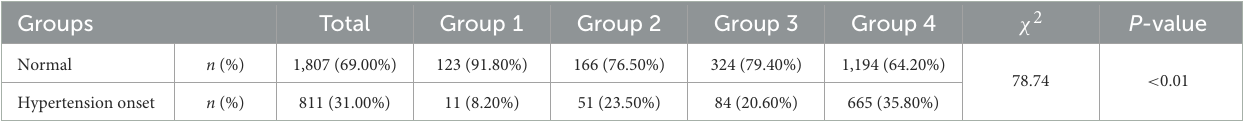
frequently observed in Group 4 ( n = 665/ N = 1,859, 35.80%) where the participants were keeping obesity status all the